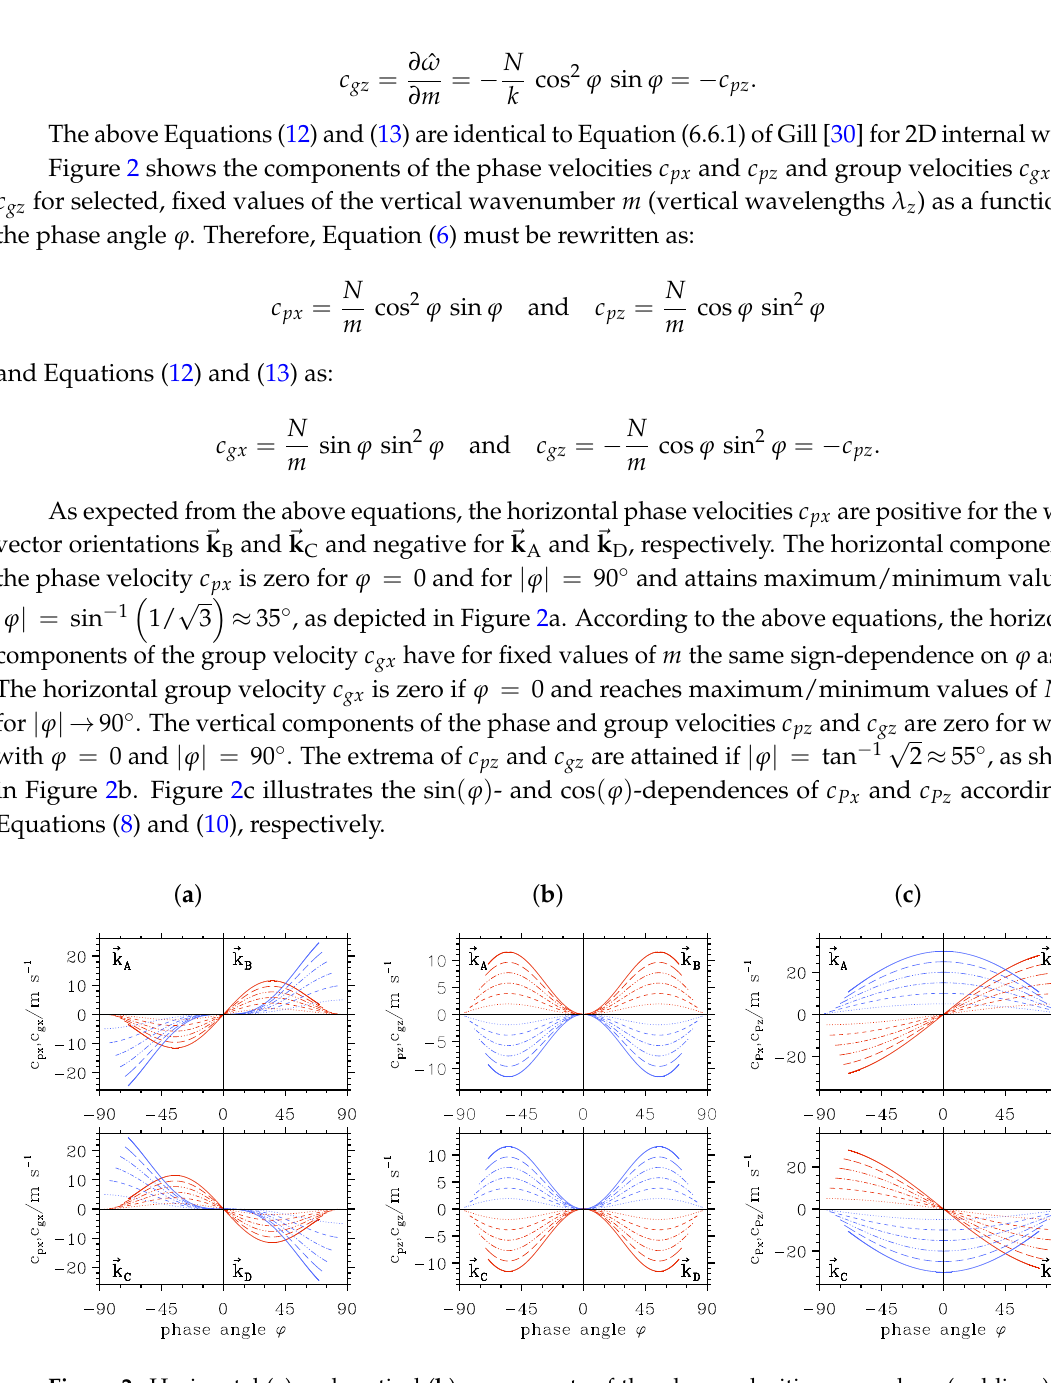
Figure 2. Horizontal ( a ) and vertical ( b ) components of the phase velocities c px and c pz (red lines) and group velocities c gx and c gz (blue lines). ( c ) Horizontal (red lines) and vertical (blue lines) phase velocities c Px and c Pz . All curves are drawn for fixed values of m > 0 (upper row) and m < 0 (lower row). Vertical wavelengths λ z = π , 2 π , 3 π , 4 π , 5 π and 6 π km are represented by lines from dotted to solid, respectively. The wavenumber vectors (cid:126) k A , (cid:126) k B , (cid:126) k C and (cid:126) k D denote the four possible orientations of the wave number vector in the respective area of the phase angle ϕ , as described in Section